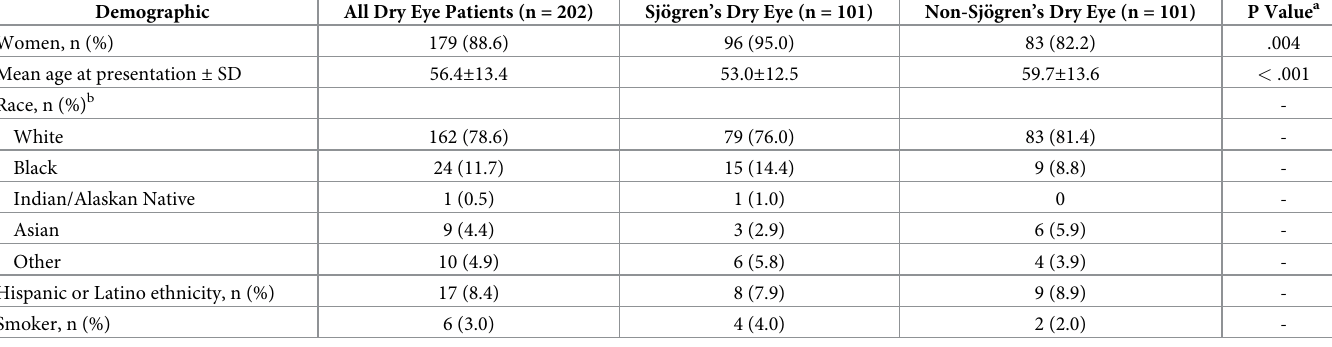
Table 2. Demographic characteristics of a longitudinal, clinic-based sample of patients with Sjo¨gren’s and non-Sjo¨gren’s dry eye disease. Demographic All Dry Eye Patients (n =